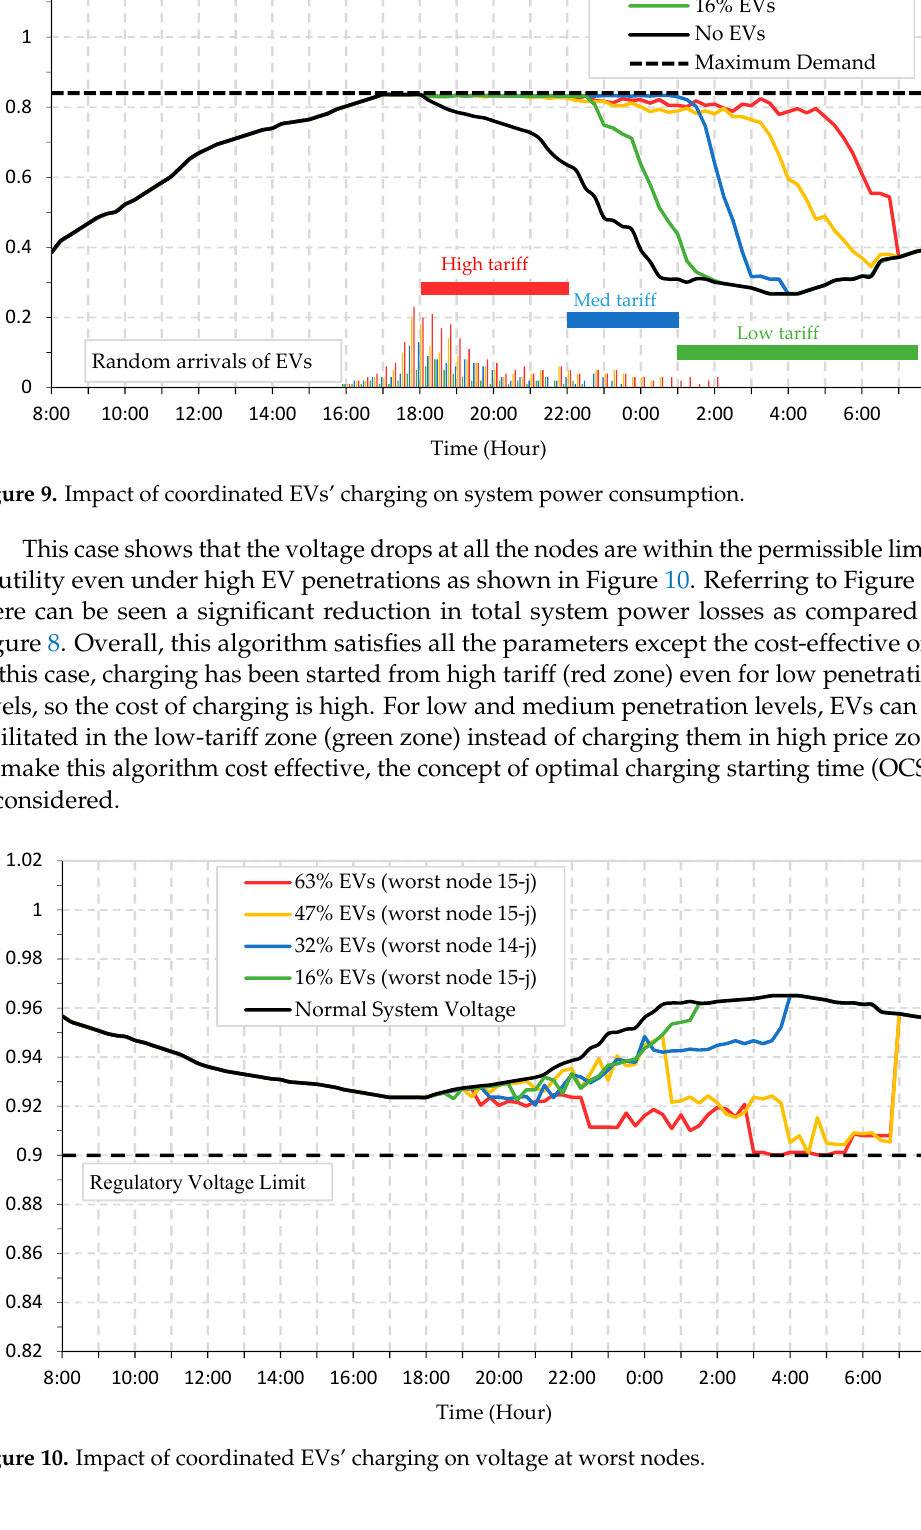
Figure 11. Impact of coordinated EVs’ charging on power loss of system. 5.2.2. Coordinated Charging Considering Optimal Starting Time (OCST) Matrix To overcome the economic aspect of the proposed algorithm, it is further modified to consider the concept of optimal charging starting time (OCST). This algorithm will shift the charging of EVs from a high-tariff zone to a low-tariff zone, considering their departure time. By doing this, a customer can save charging costs while operating in a low-tariff zone. The power consumption and optimal starting time of various penetra-